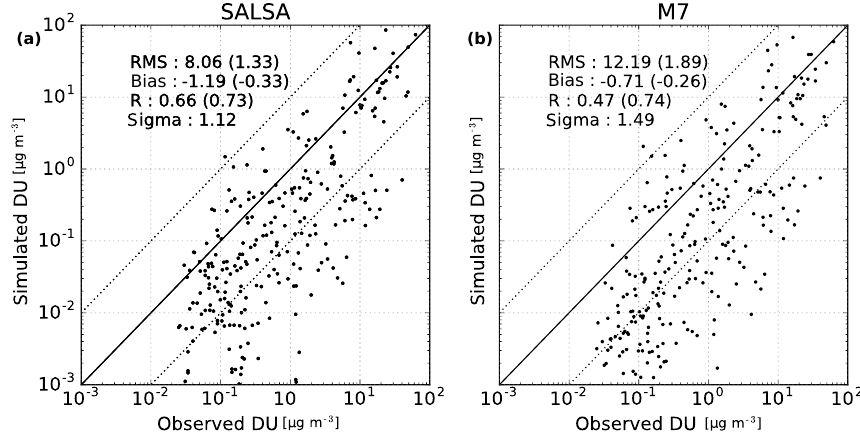
Figure 10. Scatter plots of aerosol masses observed in the SEAREX program (years 1977–1986) and the AEROCE experiment (years 1990–1995) against those from SALSA2.0 (year 2010) simulated aerosol masses for DU. The given statistical values are the same as in